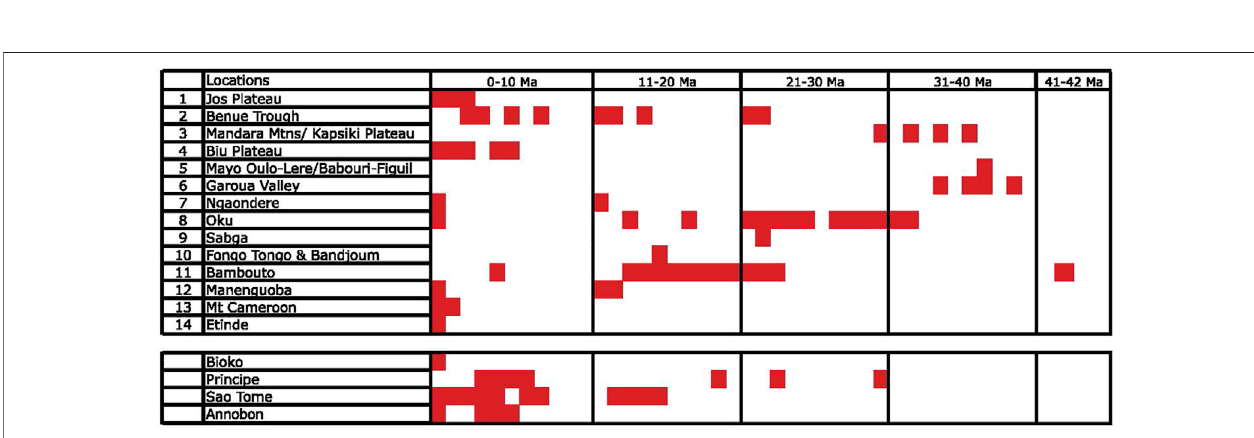
FIGURE 2 | Ages of volcanic activity at volcanic centers along the continental CVL (#1 – 14) and the oceanic portions (by island name) of the CVL. Volcanic center locations are shown in Figure 1 (Hedberg, 1969; Grant et al., 1972; Grunau et al., 1975; Dunlap and Fitton, 1979; Cornen and Maury, 1980; Dunlap, 1983; Fitton and Dunlap, 1985; Lee et al., 1994; Ngounouno et al., 1997; Marzoli et al., 1999; 2000; Ngounouno et al., 2001; 2003; Njilah et al., 2004; Ngounouno et al., 2005; 2006), illustrating the lack of age progression for initiation or cessation of volcanism along the CVL. Reproduced with permission from Reusch et al. (2010).